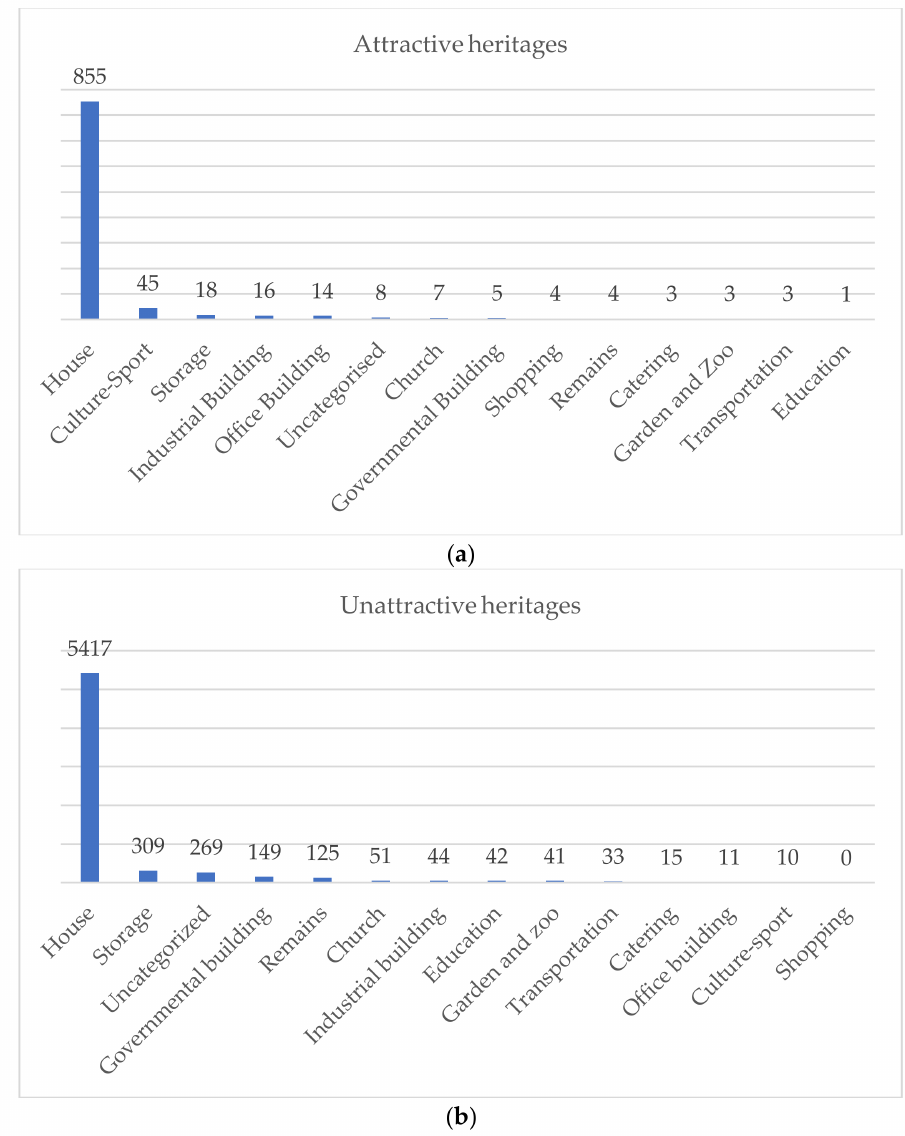
Figure 4. Distribution of heritages per type: ( a ) attractive; ( b ) unattractive. Table 2. Group of heritage